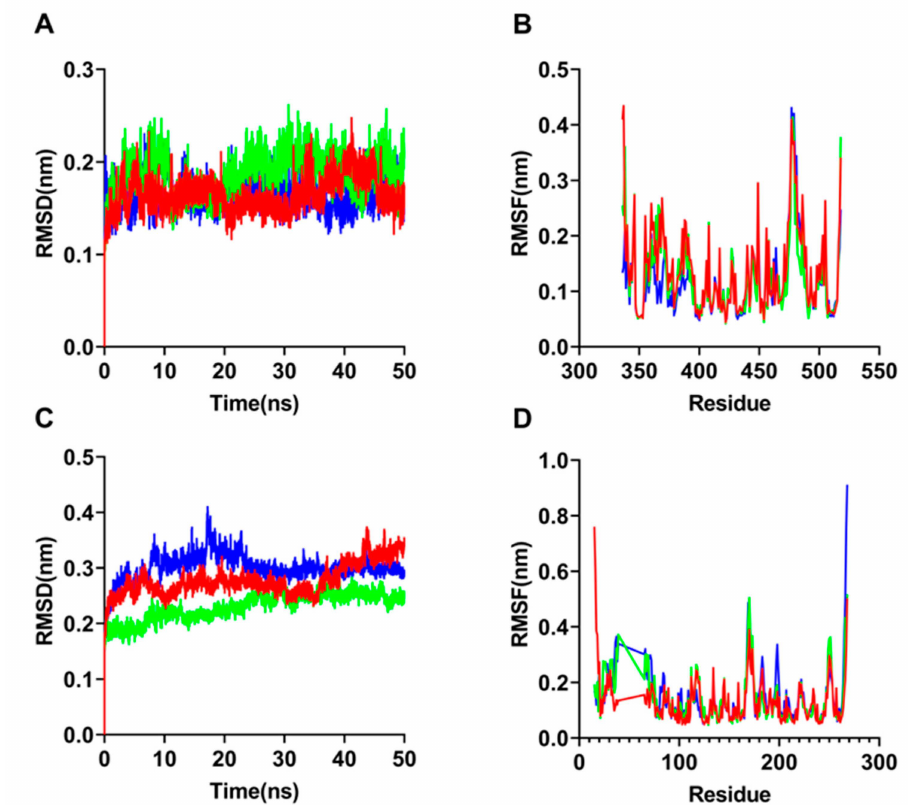
Figure 2. Analysis of RMSD and RMSF on complex of RBD-ACE2 of SARS-CoV or SARS-CoV-2. RMSD analysis on a complex of RBD-ACE2 of SARS-CoV with bioactive molecules: luteolin (red), CBNA (green) and CBGVA (blue) ( A ). RMSF analysis on residues complex of RBD-ACE2 of SARS-CoV towards the bioactive molecules: luteolin (red), CBNA (green) and CBGVA (blue) ( B ). RMSD analysis on a complex of RBD-ACE2 of SARS-CoV-2 with bioactive molecules: luteolin (red), stigmasterol (green) and CBNA (blue) ( C ). RMSF analysis on residues complex of RBD-ACE2 of SARS-CoV-2 towards the bioactive molecules: luteolin (red), stigmasterol (green) and CBNA (blue) ( D ). The RMSDs for RBD-ACE2 of SARS-CoV were found to be lowest and highest for stigmasterol and CBNA, respectively. These top three molecules have sizes ranging from 0.2 to 0.35 nm and a low magnitude, making them more stable than those of SARS-CoV-2 (Figure 2C). RMSF analysis revealed that the bioactive region with residues had substan-